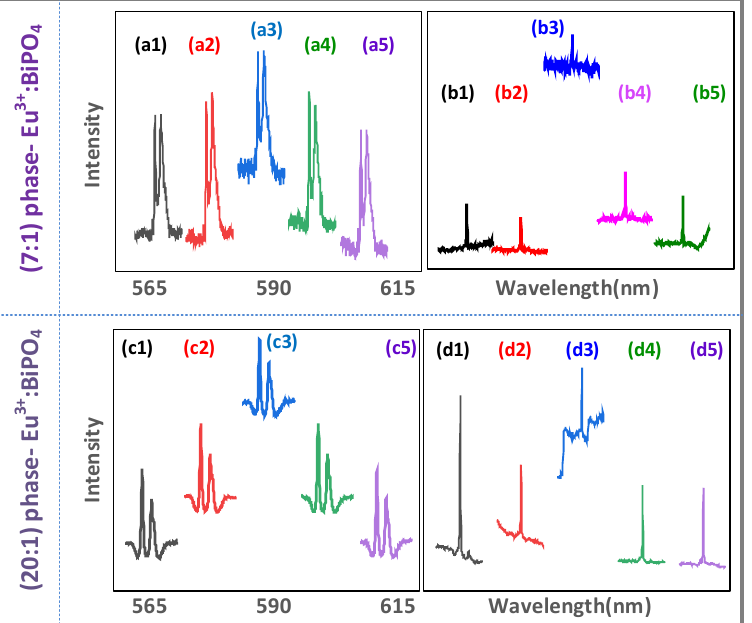
Figure 4. ( a1 – a5 , b1 – b5 ) show SFWM cross-interaction observed from Eu 3+ doped BiPO 4 [molar ratio (7:1)] at different narrowband laser E 2 (567.4 nm, 587.4 nm, 588 nm, 588.4 nm, 602.4 nm) while broadband laser E 1 is scanned from 572.4 nm to 612.4 nm at different broadband laser E 1 wavelengths (567.4 nm, 584.4 nm, 587.4 nm, 596.4 nm, 612.4 nm) and narrowband laser E 2 is scanned from 567.4 nm to 607.4 nm at 300 K, respectively, at PMT1. The time gates are 5 µ s and 20 µ s, respectively, gate width = 400 ns. ( c , d ) show SFWM cross-interaction for the (20:1) sample at the time gate = 10 µ s and 20 µ s, respectively. The other experimental condition is the same as ( a , b ), respectively, at PMT1.